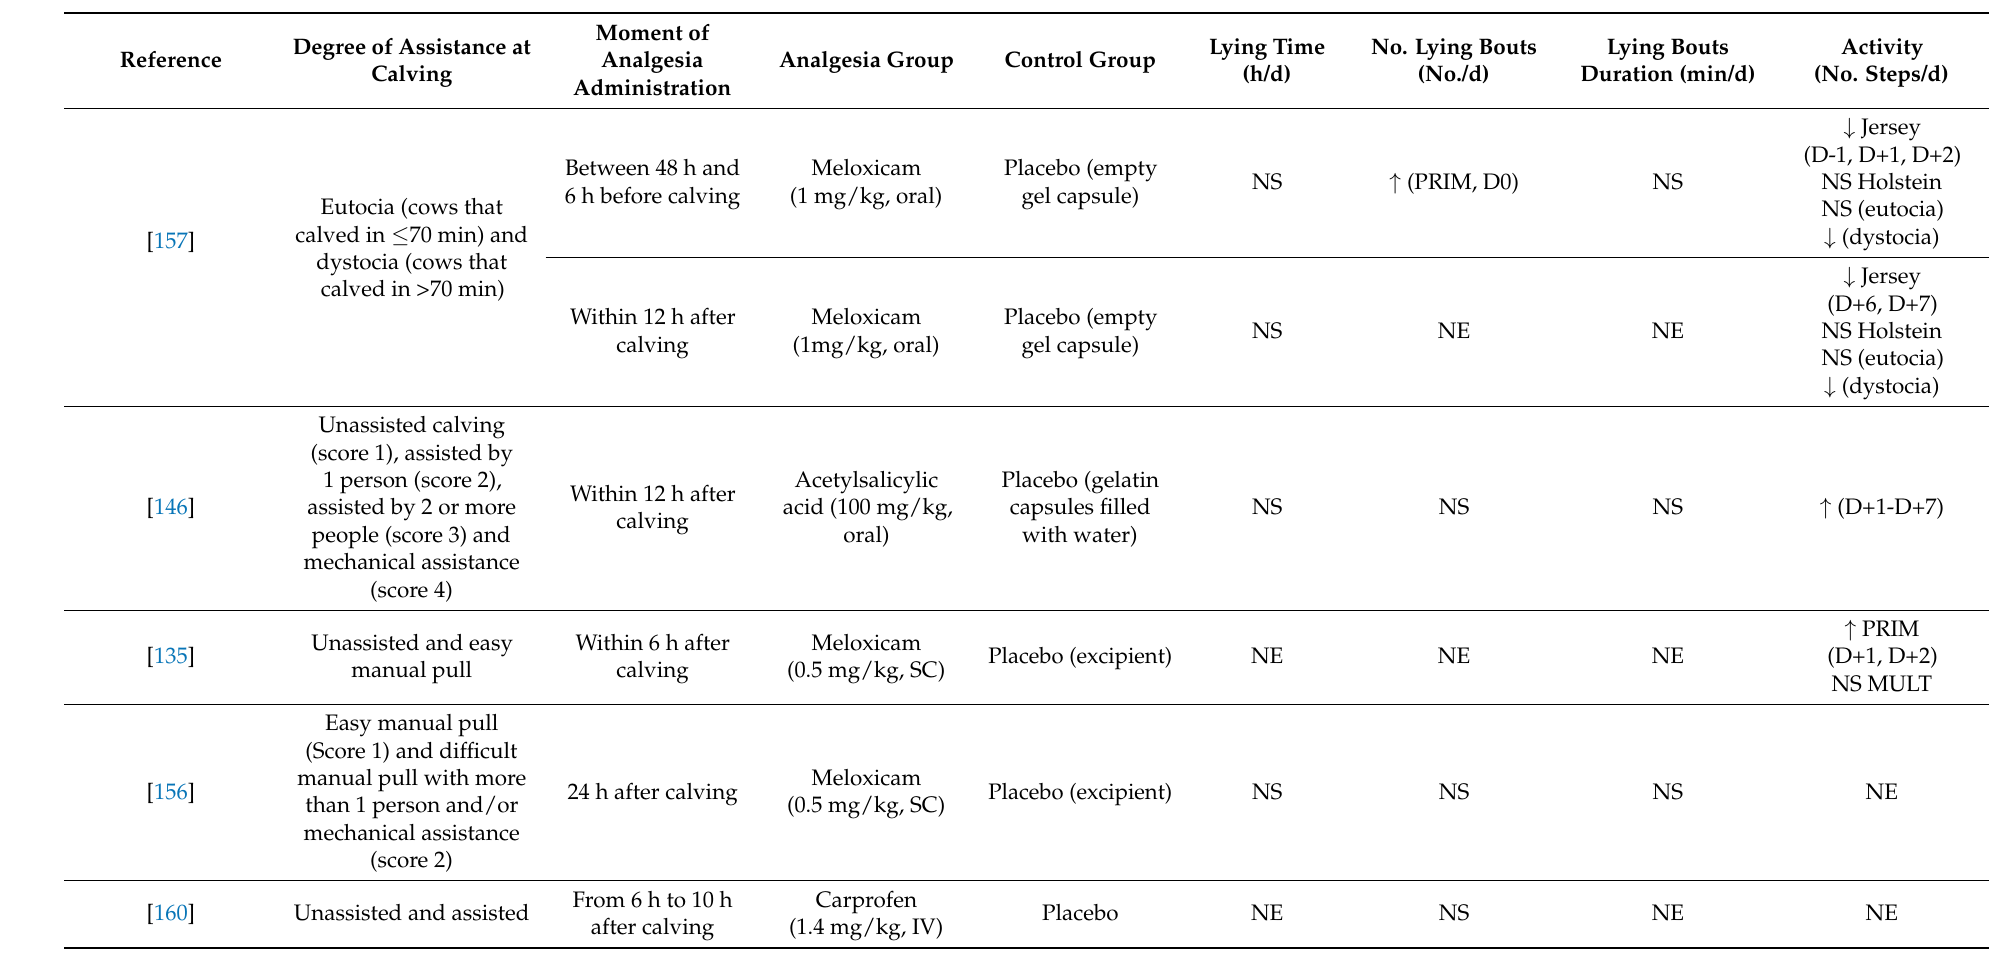
Table 5. Summary of changes in activity patterns in cows (lying time, number of lying bouts, lying bout duration and activity) caused by calving, observing cows with and without analgesia (analgesia vs. control group). Degree of assistance at calving and moment of analgesia administration are documented. Moment (in days, D; D0 = day of calving) and type of change ( ↑ increase; ↓ decrease; NS = non-significant; NE = non-evaluated) are given comparing the analgesia group with control group cows. Primiparous cows (PRIM) and multiparous cows (MULT) are